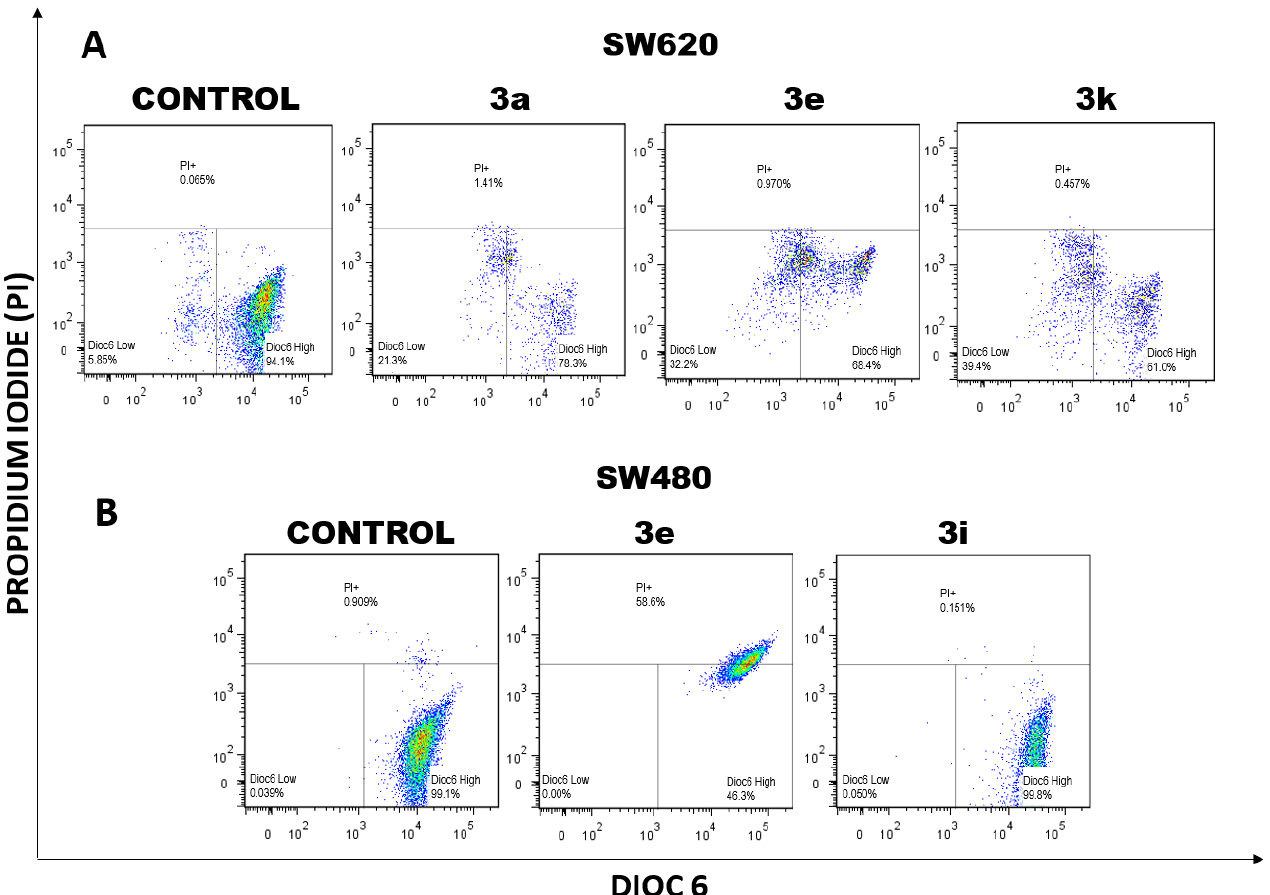
Figure 1. Changes in ∆Ψ m and plasma membrane integrity induced by curcumin–resveratrol hybrids. Flow cytometry of cells stained with DiOC6 and PI. ( A ) SW620 cells. ( B ) SW480 cells. DiOC6 Low and PI+: cells in latency that lose membrane polarization and dead cells; DiOC6 High: live cells with high membrane polarization. One representative image is shown.